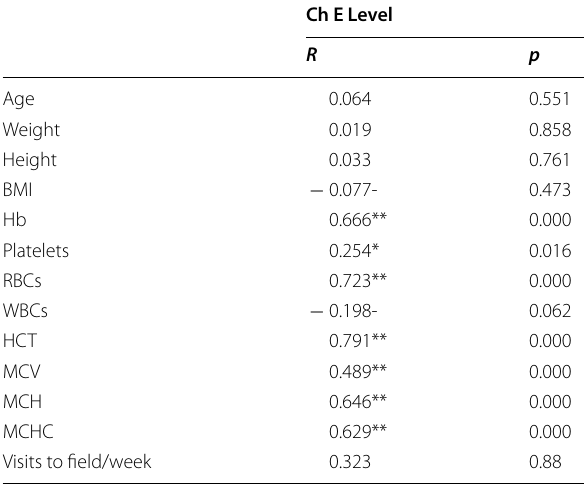
Table 5 Correlations between cholinesterase and other study